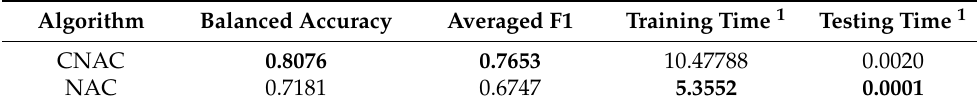
Table 4. Performance of the proposed Customized Naïve Associative Classifier vs.